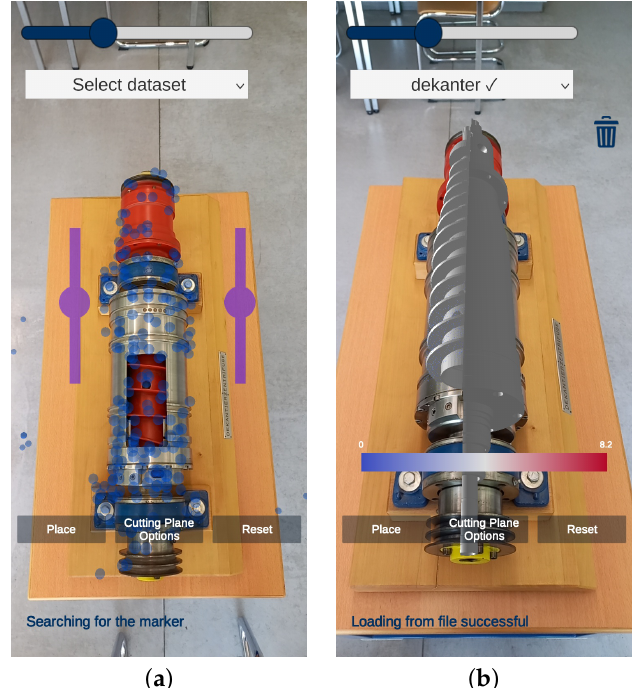
Figure 10. Example of geometry overlay on a decanter centrifuge. ( a ) Decanter preplacement with visible feature point tracking. ( b ) Decanter overlaid over real decanter